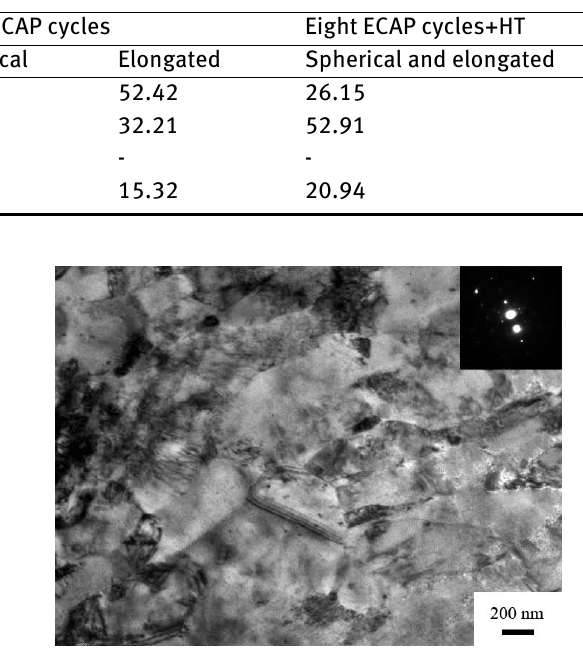
Figure 6: Structure (TEM) of the Cu-0.55Cr-0.2Cd-0.02Zr alloy after eight ECAP cycles + TO at 400 ∘ C for 1 h.